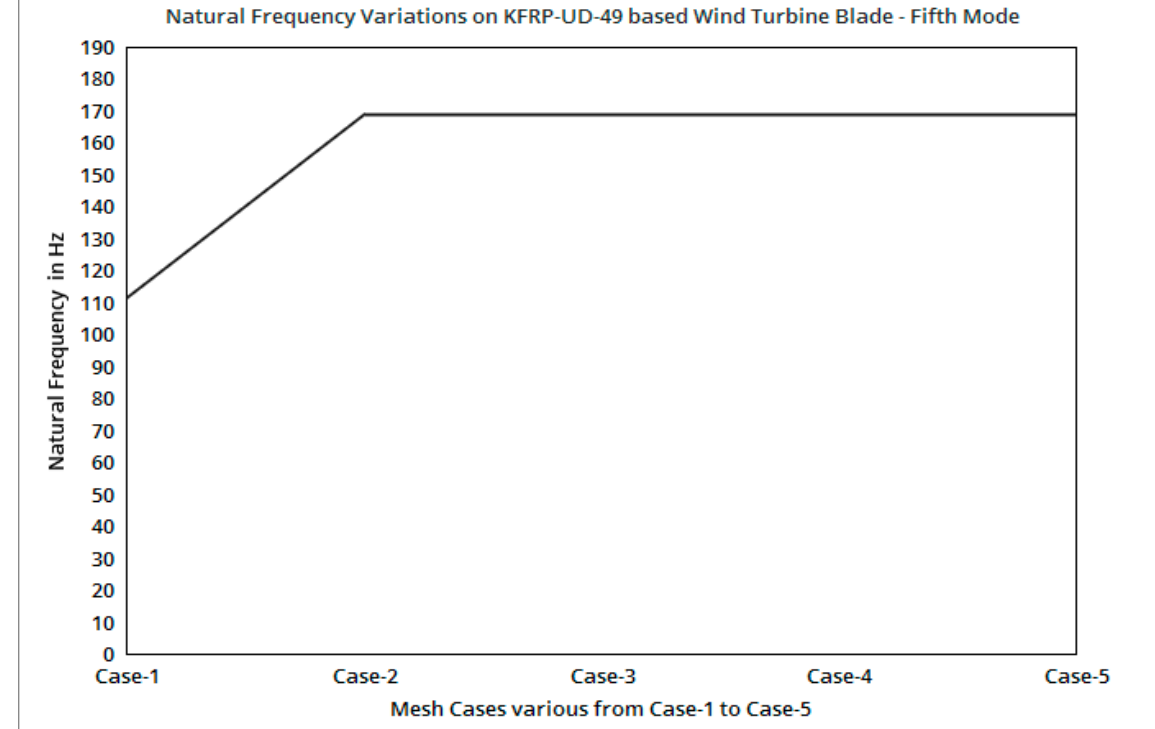
Figure 13. Grid convergence test 2: natural frequency of KFRPwind turbine blade.